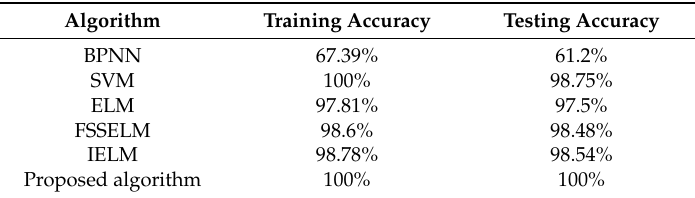
Table 2. Accuracy comparison among six classifiers.